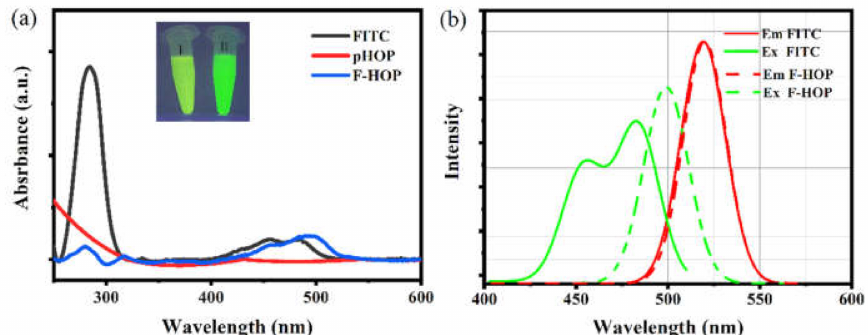
Figure 6. ( a ) UV-Vis absorption spectra of free FITC (black), pHOP (red), and F-HOP samples (blue). The inset shows the photograph of FITC solution (I) and the F-HOP sample (II) under UV light (385 nm). ( b ) Fluorescent excitation (green) and emission (red) spectra for free FITC (solid) and F-HOP (dashed) samples measured in